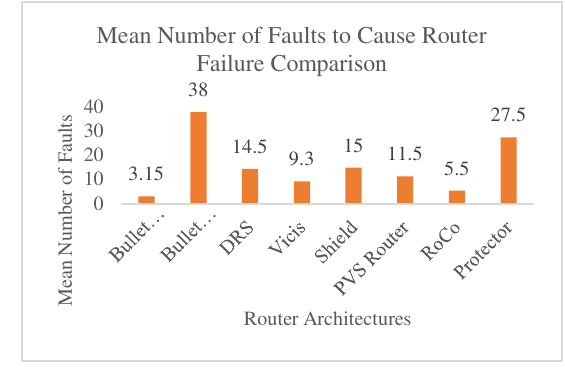
FIG. 15: COMPARISON OF MEAN NUMBER OF FAULTS Fig. 16 provides a comparison with state of the art by